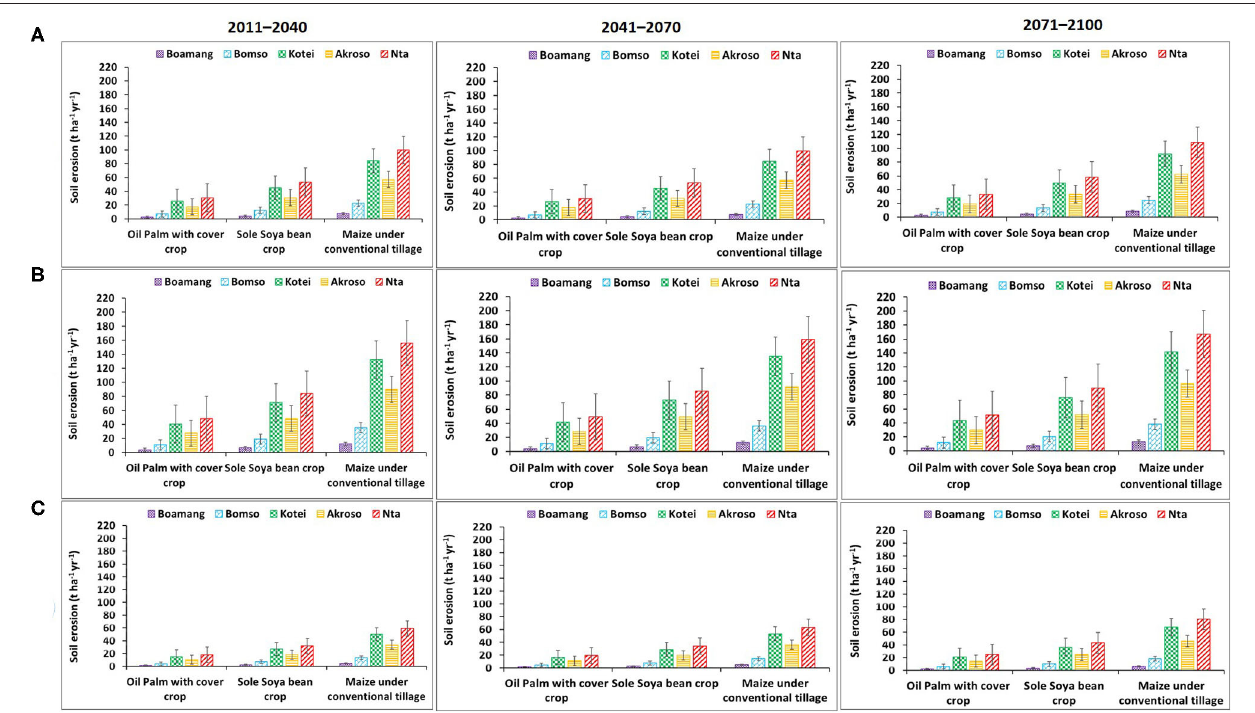
FIGURE 5 | Predicted soil loss under climate change impact using (A) CCCma-CanESM2, (B) GFDL-ESM2M, and (C) HadGEM2-ES model outputs.